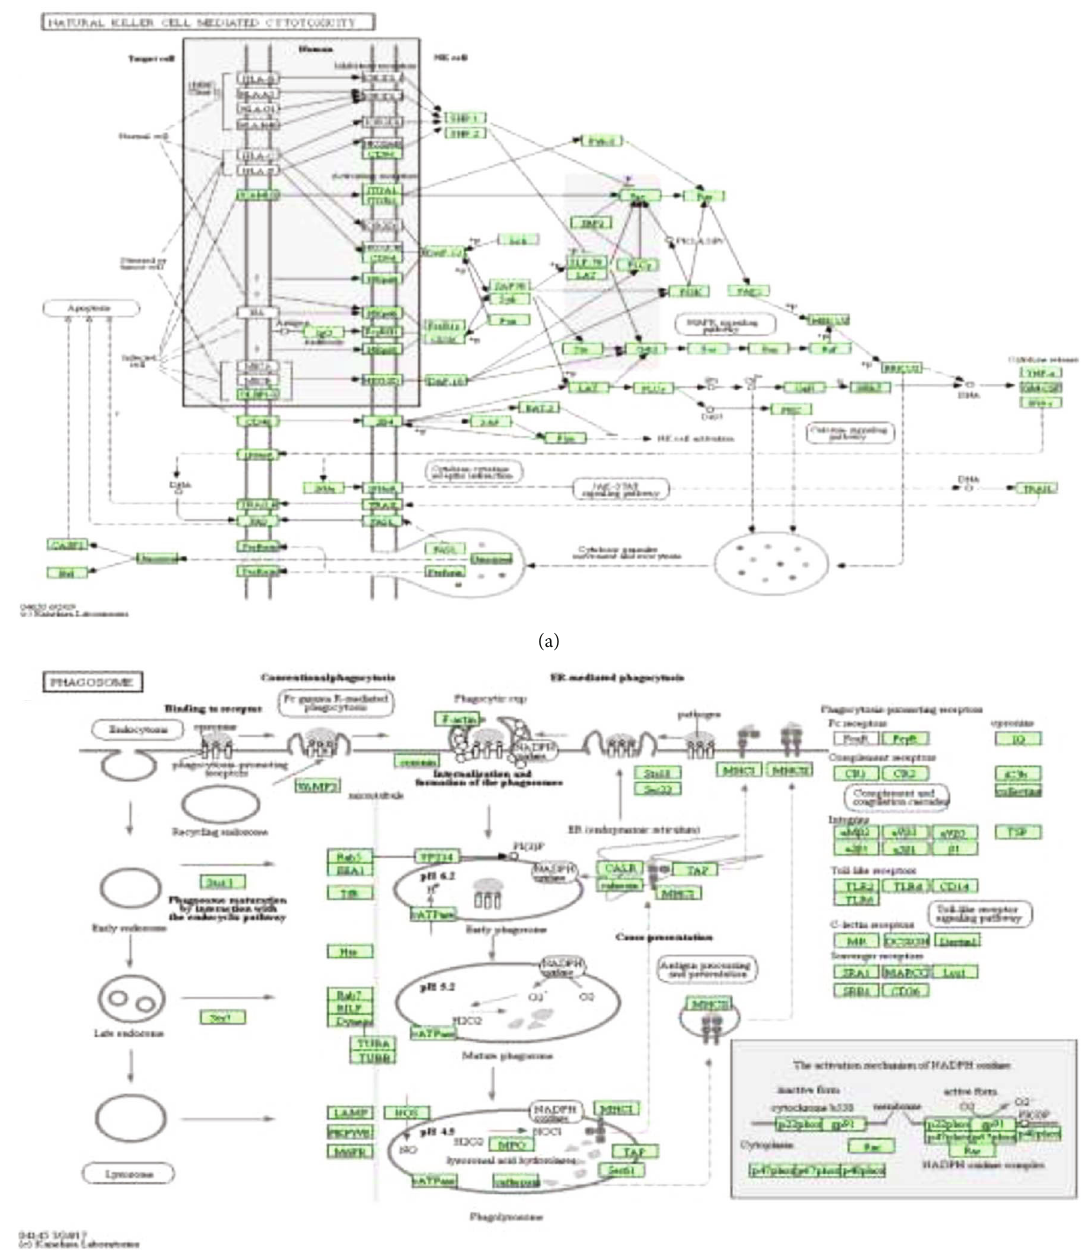
Figure 7: DAVID was used to analyze 14 selected key genes. 14 highly expressed genes related to poor prognosis in LGG tissues were reanalyzed by KEGG pathway enrichment. Three DEGs (FCER1G, ITGB2, TYROBP) and three DEGs (ITGB2, CTSS, ITGAM) were signi fi cantly enriched in NKCC and phagosome pathways, respectively ( P < 0 : 05